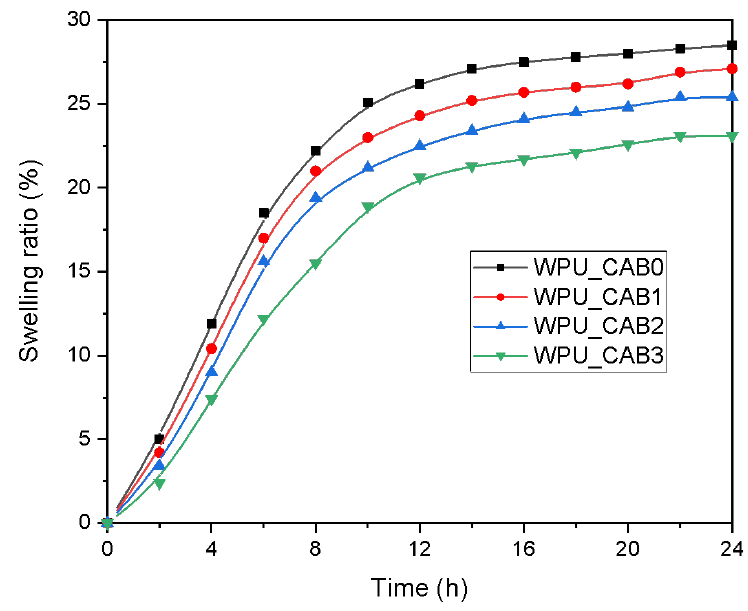
Figure 8. Changes in the swelling ratio of WPU films as a function of time.